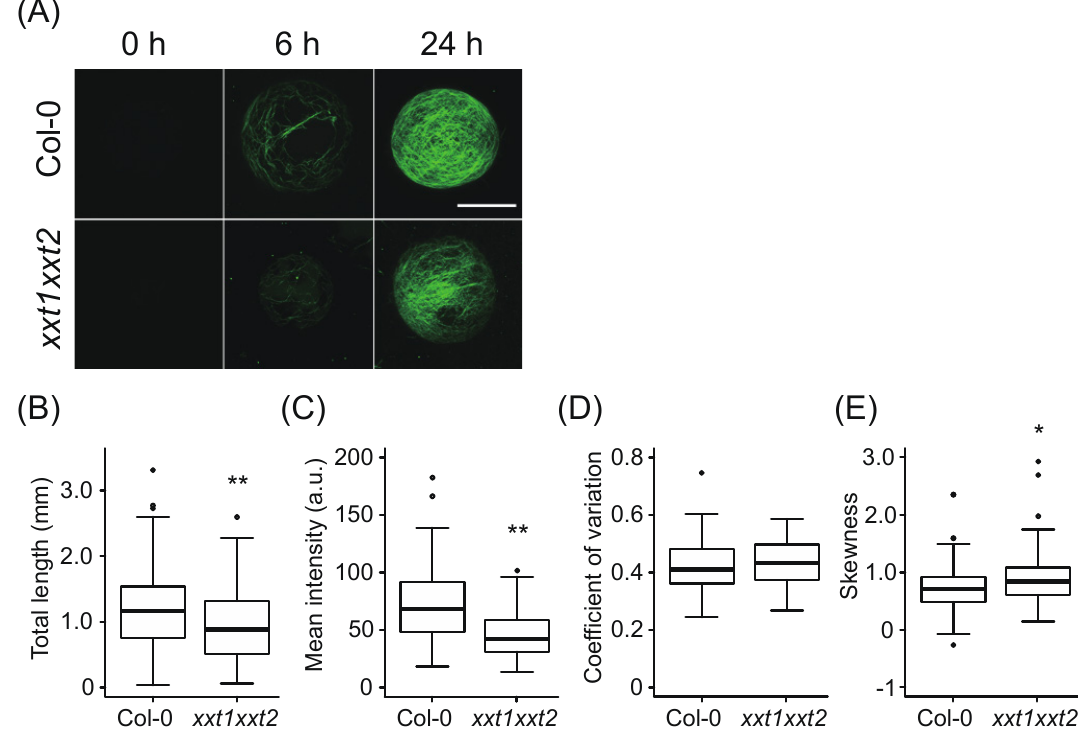
Figure 1. Comparison of cell wall regeneration between WT (Col-0) and xxt1 xxt2 protoplasts. ( A ) Representative images of network structure in the cell wall of Col-0 and xxt1 xxt2 protoplasts incubated for 0, 6, and 24 h and stained with Calcofluor. ( B – E ) Total length ( B ), mean intensity ( C ), coefficient of variation (CV) of fluorescence intensity distribution ( D ), and skewness of fluorescence intensity distribution ( E ) of the network measured at 24 h. Center lines of box-plot show the medians, boxes indicate interquartile range (IQR), whiskers indicate 1.5 IQR, and outliers are shown by dots.